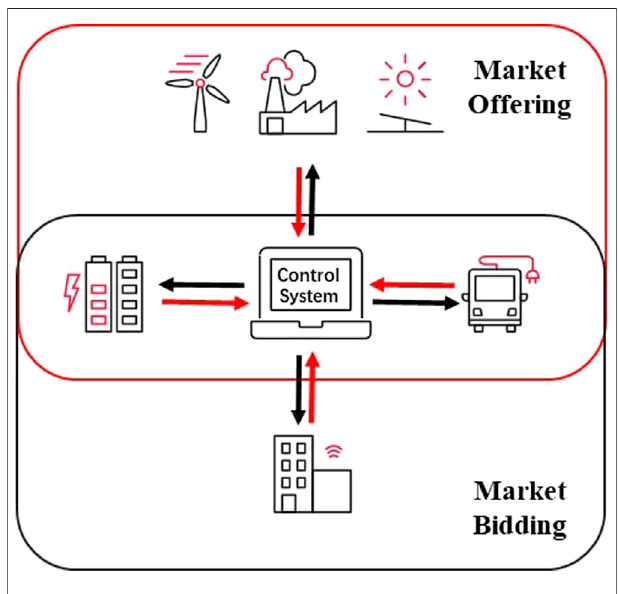
FIGURE 2 | Basic formation of integrated energy